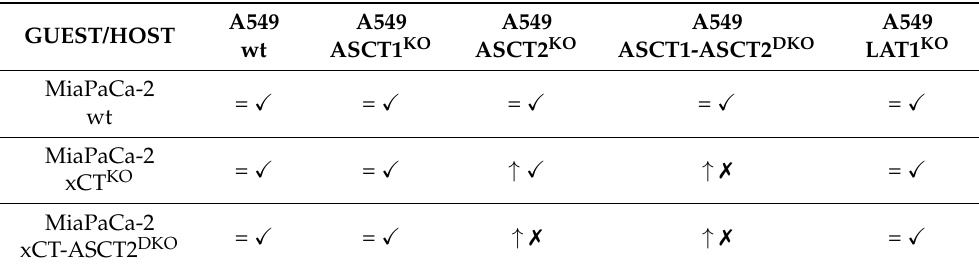
Table 1. Summary of the different combinations of the mutations in the “host” and “guest” cells and their effect on the lipid hydroperoxide profile and cell